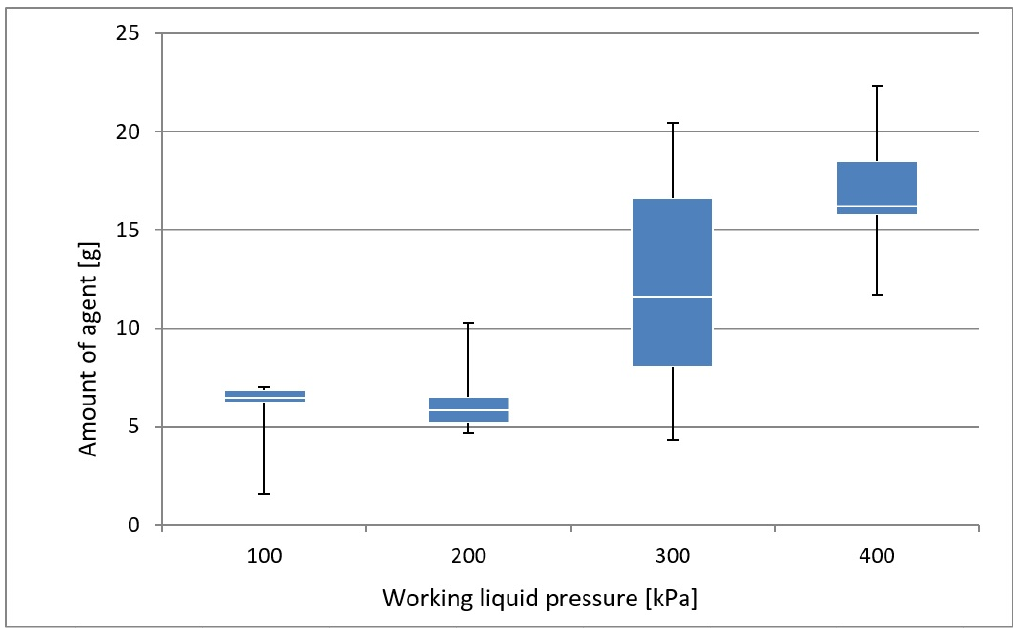
Figure 9. The amount of the agent lost (applied outside the seed potato surface) for the electronically controlled valve for the 50-mm distance between the valve and the seed potato falling path (air pressure reduced by 50 kPa—intermittent stream of the liquid).